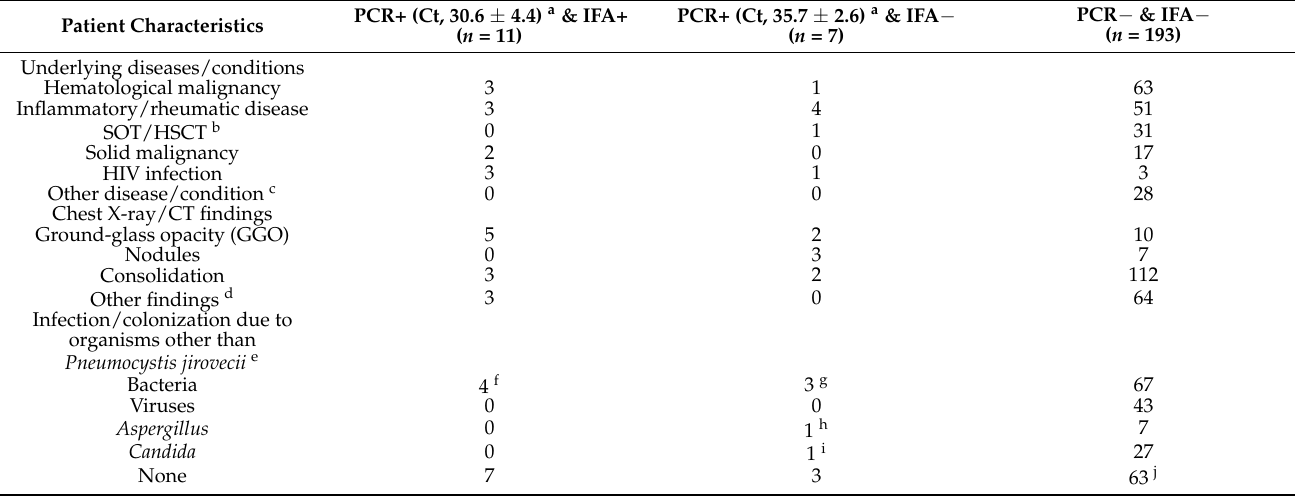
Table 1. Microbiological results for 211 BAL fluid samples from patients with suspected